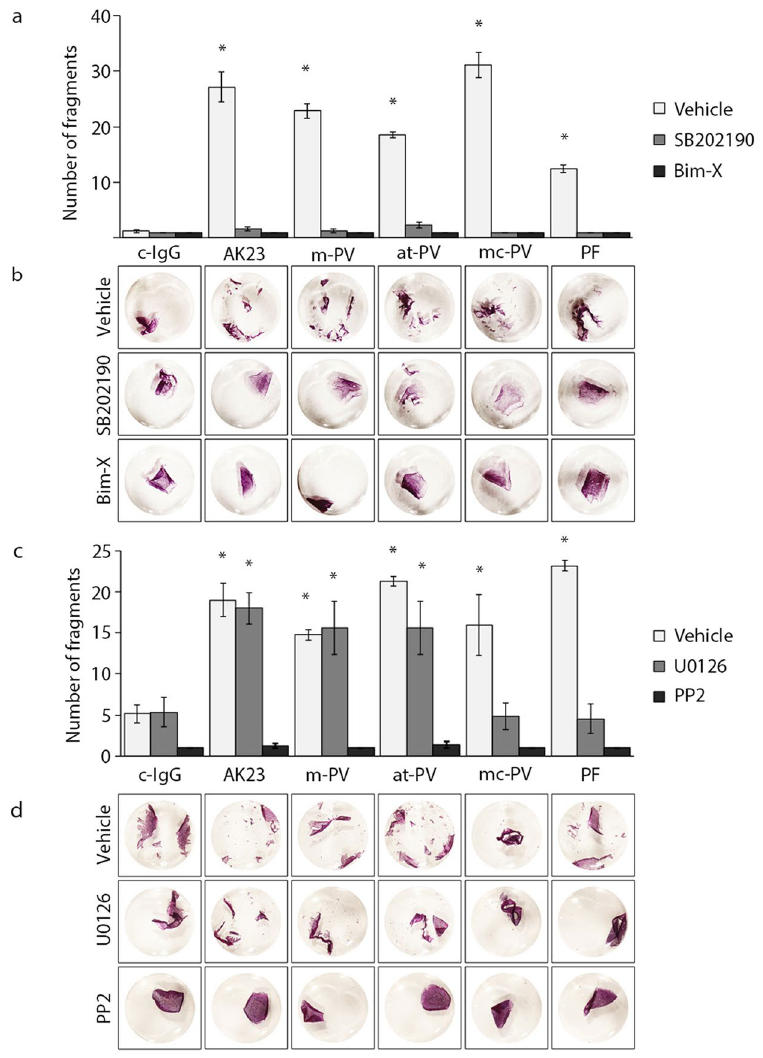
Figure 4. Adhesion measurements with modulation of signaling molecules. Dispase-based dissociation assays in HaCaT keratinocytes after applying the specific inhibitors SB202190 (p38MAPK), Bim-X (PKC), U0126 (Erk) or PP2 (Src) for 1 h, followed by either ( a ) 24 h incubation of IgG fractions or ( c ) 2 h incubation of IgG fractions (n = 4; * p ≤ 0.05 vs. c-IgG with the respective mediator). ( b , d ) Representative images of monolayers incubated with 10 μ m MTT to visualize cell